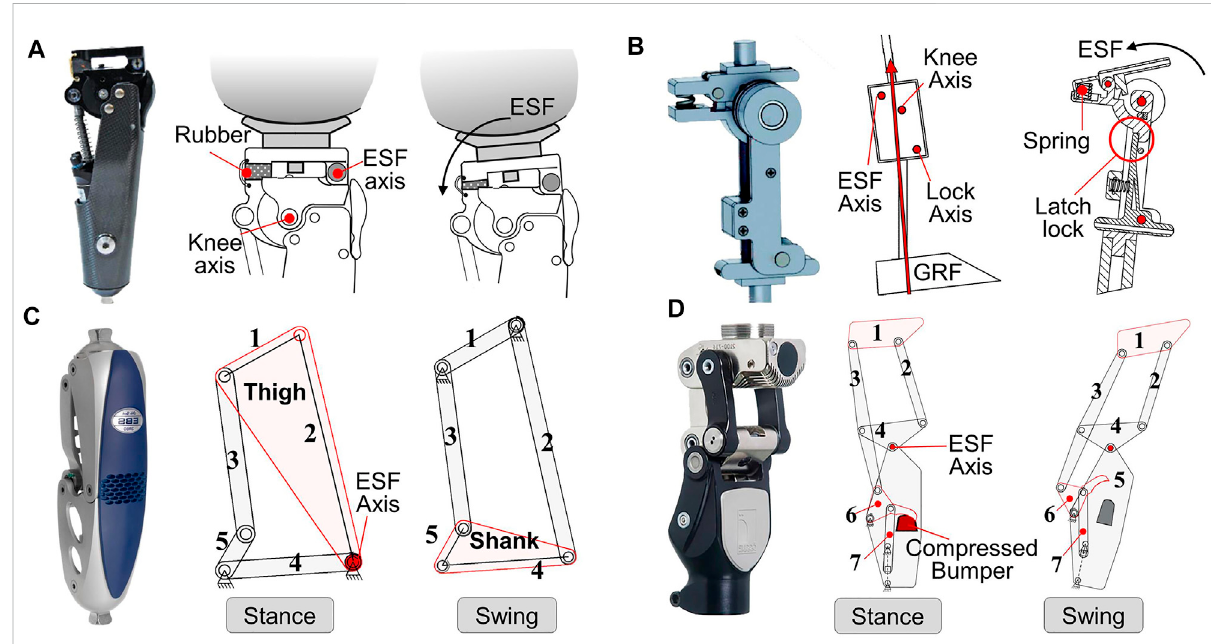
FIGURE 9 Prosthetic knees with the ESF-axis mechanism. (A) Knee with the weight-activated brake and ESF-axis structure (Blatchford ® ESK + , Blatchford and Tucker, 1980), reproduced with permission from copyright 1980 by Blatchford ® . (B) Prosthetic knee with the lock-axis and ESF-axis structures (Arelekatti and Winter, 2015), reproduced with permission from copyright 2019 by MIT. (C) Knee with the ESF-axis mechanism based on fi ve-bar linkage (Ottobock ® 3R60, Blumentritt et al., 1997), reproduced with permission from copyright 1997 by Ottobock ® . (D) Knee with the